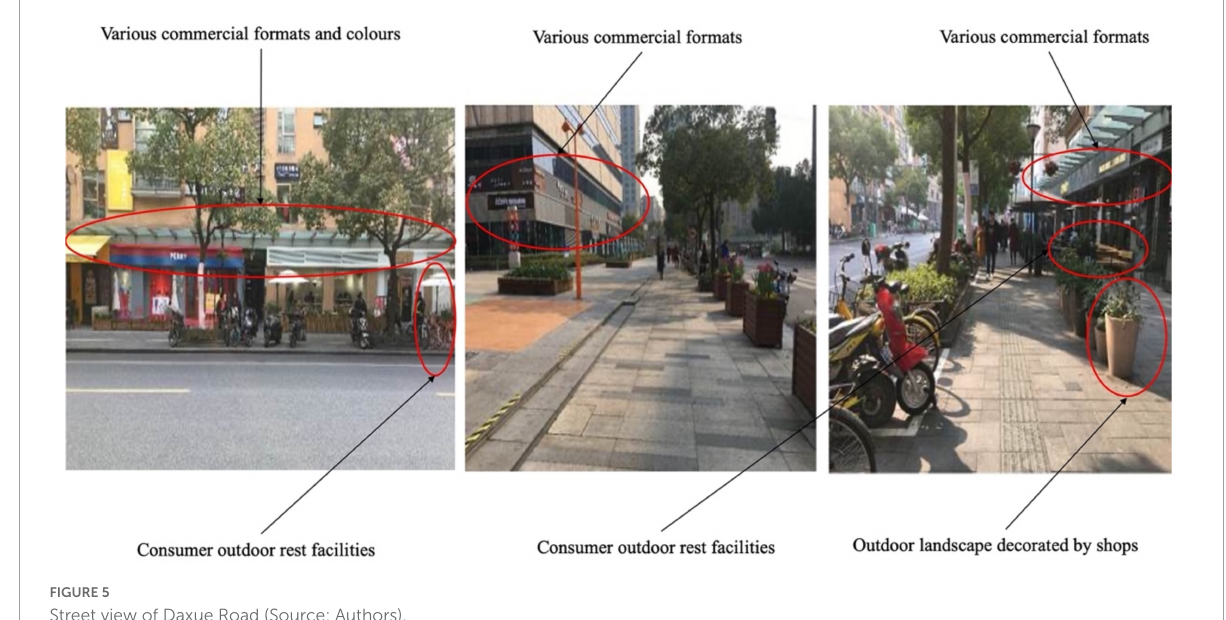
FIGURE5 Street view of Daxue Road (Source: Authors).